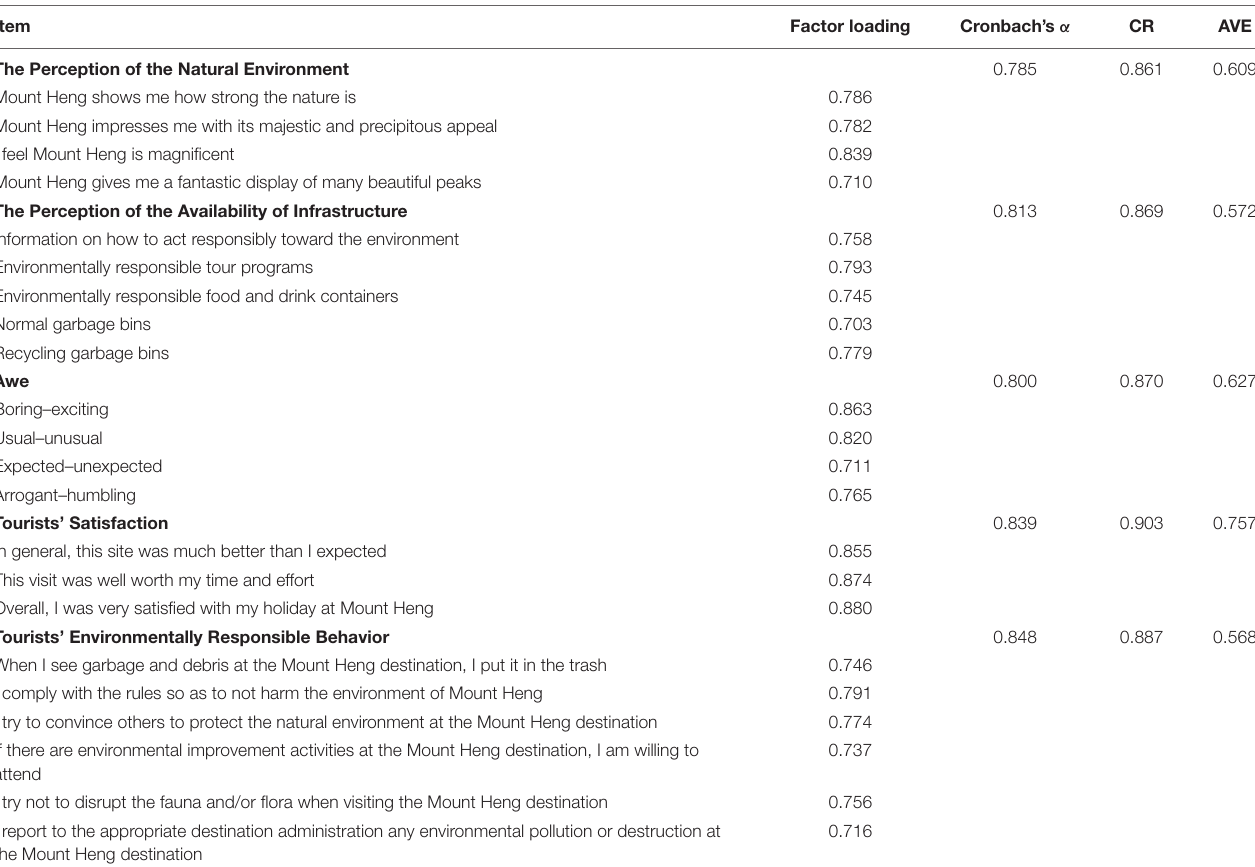
TABLE 2 | Construct reliability and convergent validity.